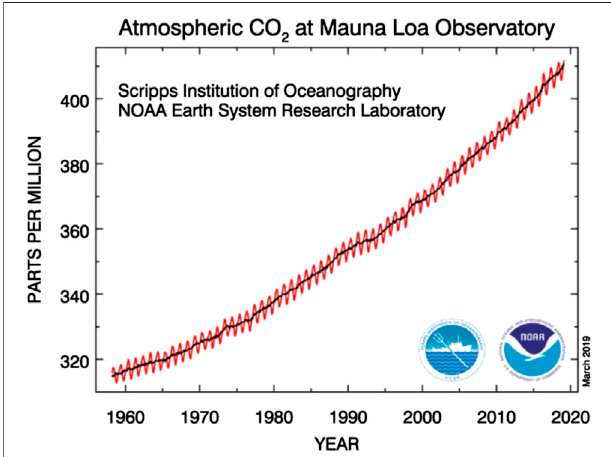
FIGURE 1 | Concentrations of CO 2 in the atmosphere measured at Mauna Loa Observatory (Hawaii) since the beginning of the measurements in March 1958 (316 ppm) (Tans, 2019).